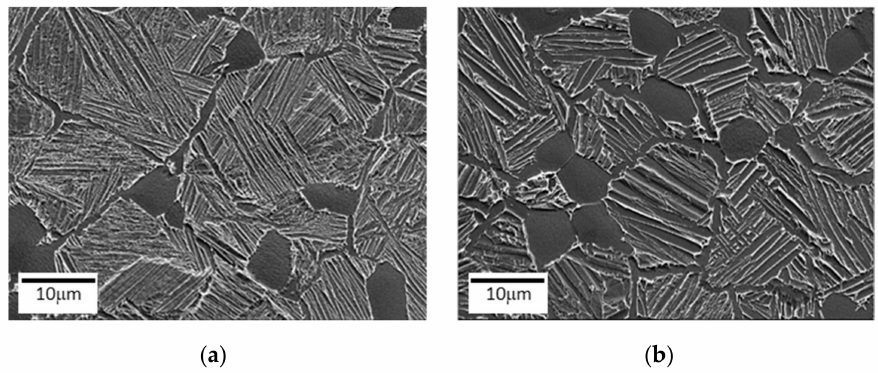
Figure 3. Control of secondary α lath width under 840 ◦ C solution heat treatment. ( a ) “fast” air cooling, ( b ) “slow” vermiculite